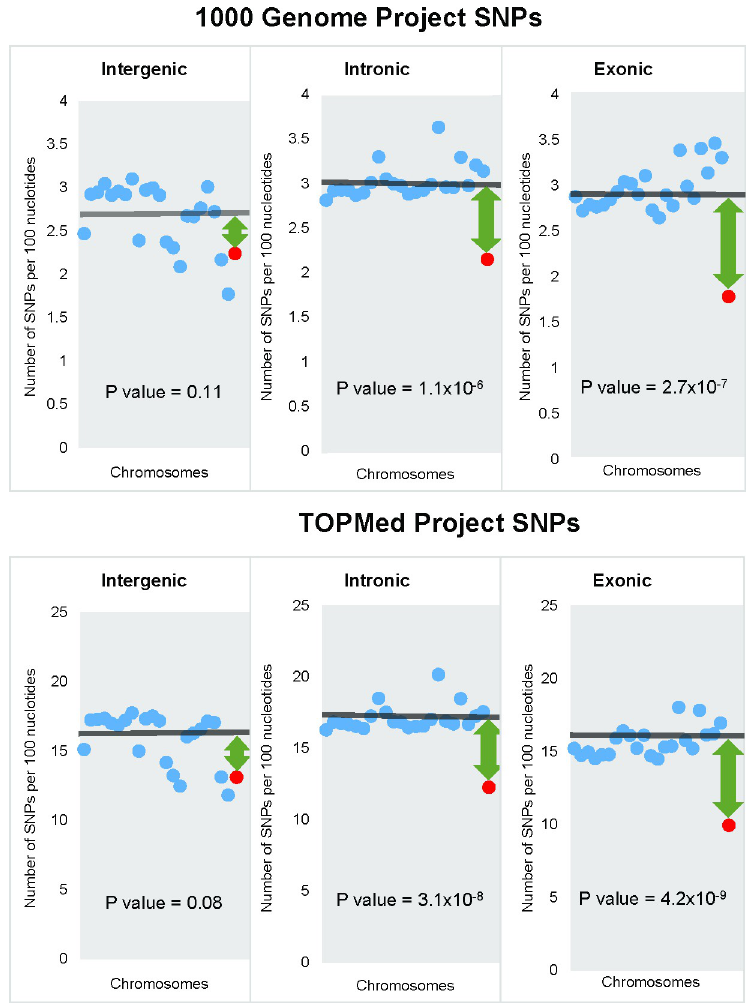
Fig 7. The densities of 1KG and TOPMed SNPs in intergenic, intronic and exonic regions. Each dot represents a chromosome: blue dots–autosomes and red dot–X- chromosome. Horizontal lines show the mean SNP density for all autosomes. Green arrows depict the difference between the mean autosomal and X-chromosome densities. Positions of chromosomes on the Fig from left to right correspond to chromosomal numbers. slightly higher: 3.0 ± 0.1 and 1.8, correspondingly (p = 2.2x10 -7 ). The results for TOPMed SNPs were similar to the results for 1KG SNPs (lower panel of Fig 7).